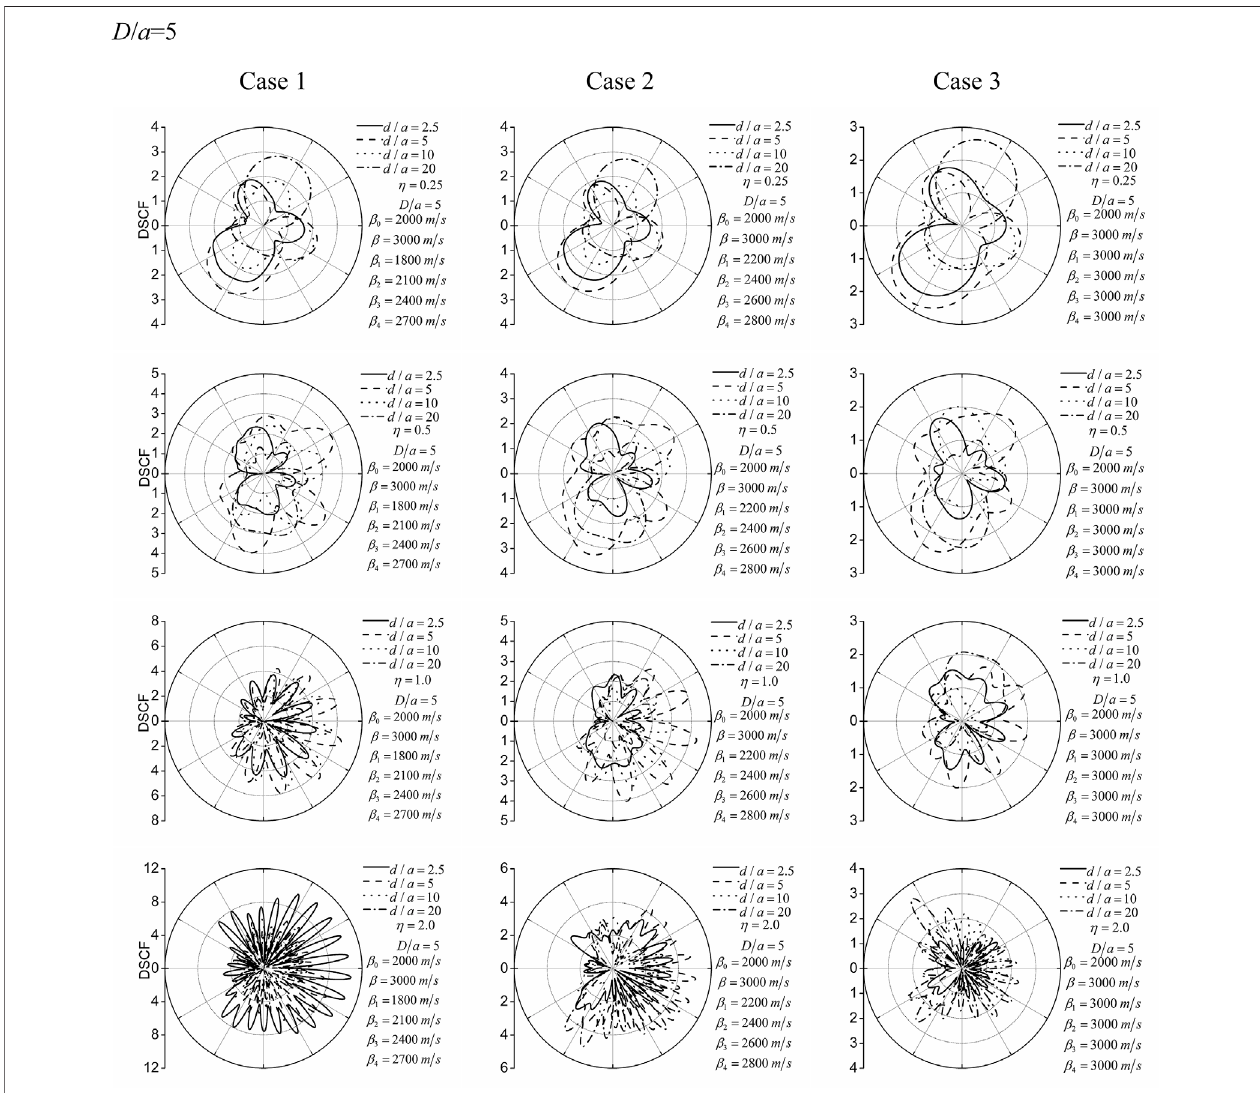
FIGURE 4 | The same as Figure 3 but for the lining burial depth D / a (cid:1) 5.